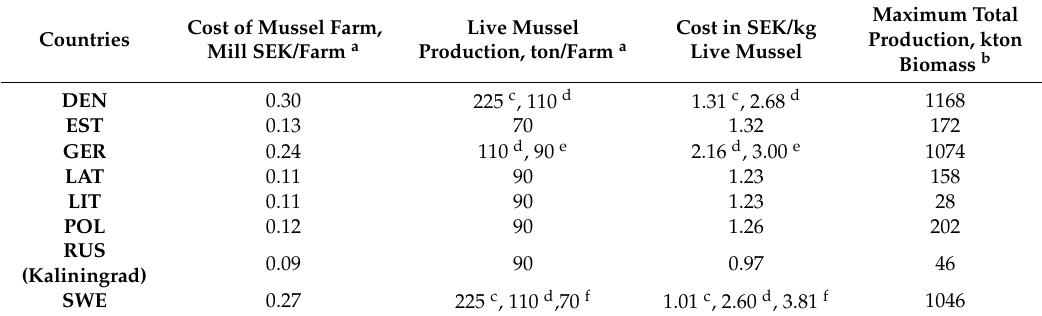
Table A2. Costs of mussel farming in 2015 prices, biomass production, and maximal total production in Kattegat, the Danish Straits, and Baltic